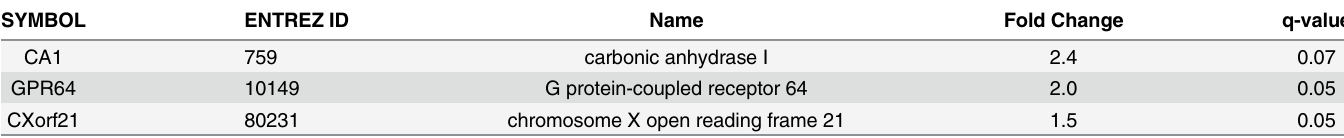
Table 8. A list of the 3 differentially expressed transcripts in the visceral adipose tissues between the pregnant and non-pregnant